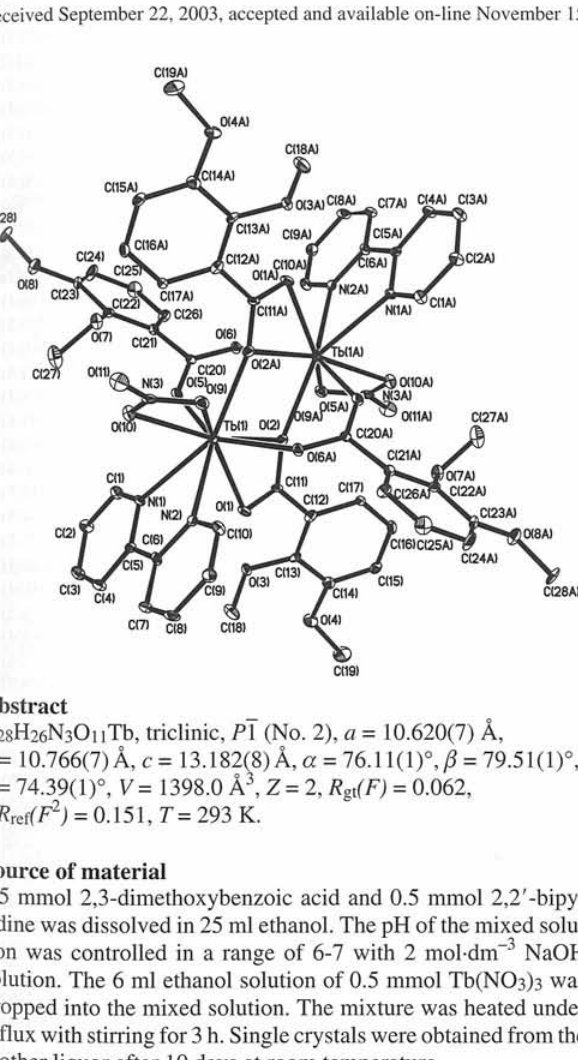
Table 2. Atomic coordinates and displacement parameters (in